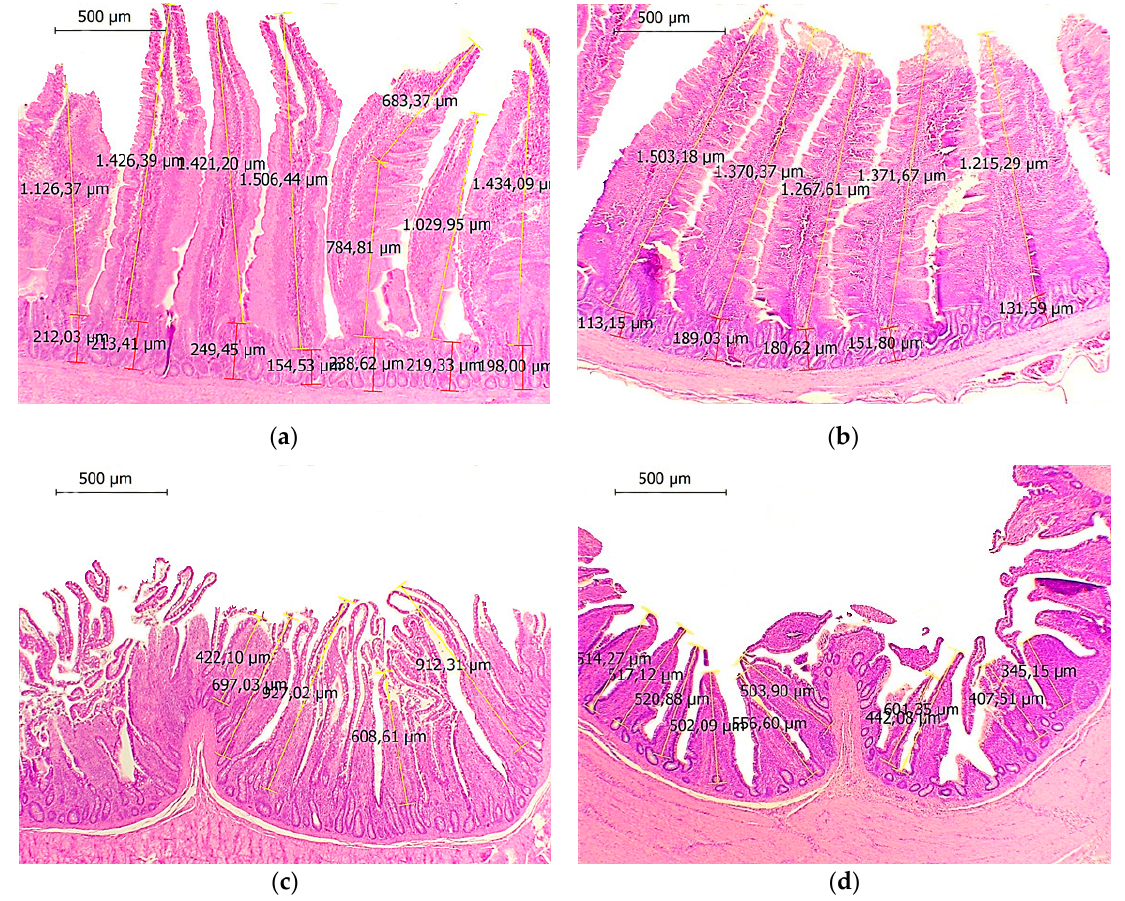
Figure 1. Histomorphometric images of 50-week-old laying hens of a supplemented (left) and a control group (right). The duodenal villi height and the crypt depth were significantly deeper in the supplemented group ( a ) compared to controls ( b ). In the rectum, villi were significantly higher in the supplemented group ( c ) compared to controls ( d ). Hematoxylin-eosin stain, 40×.